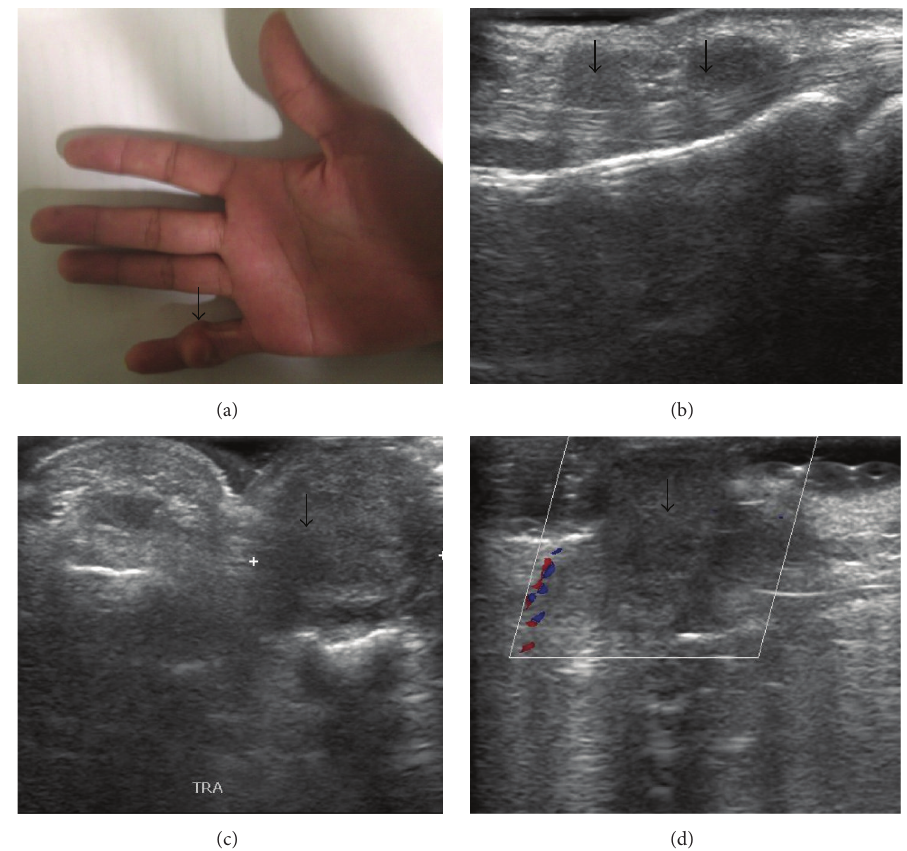
Figure 3: Giant cell tumorof tendon sheath. A 20-year-old female presented with swelling in right 5th finger over middle phalanx ((a), arrow). Ultrasonography and Doppler show multiple well-defined, hypoechoic, hypovascular lesions along the flexor tendons ((b)–(d),